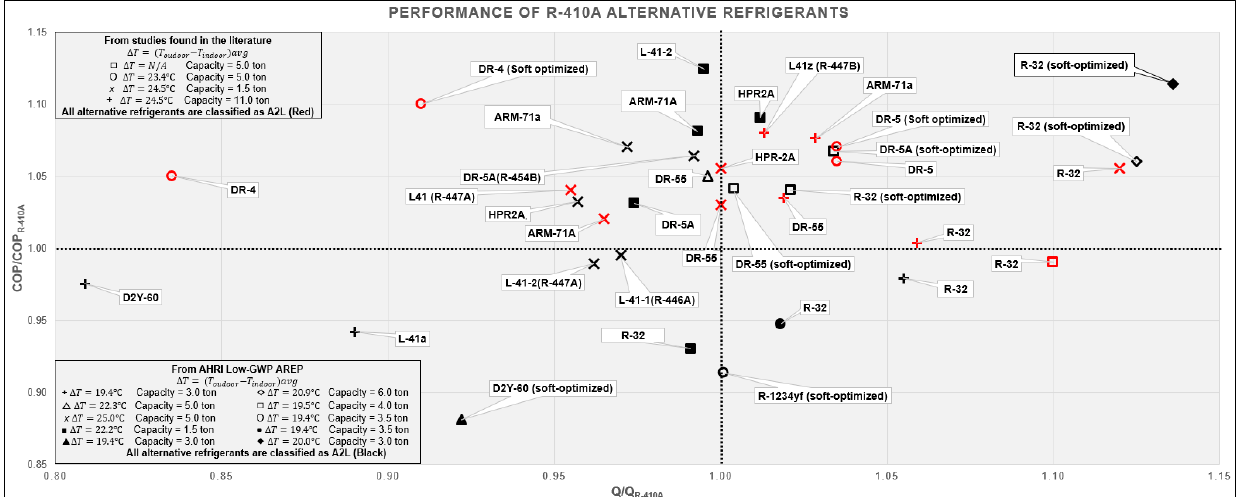
Figure 9. Experimental results for R-410A alternative refrigerants at HAT conditions, where Q is cooling capacity.